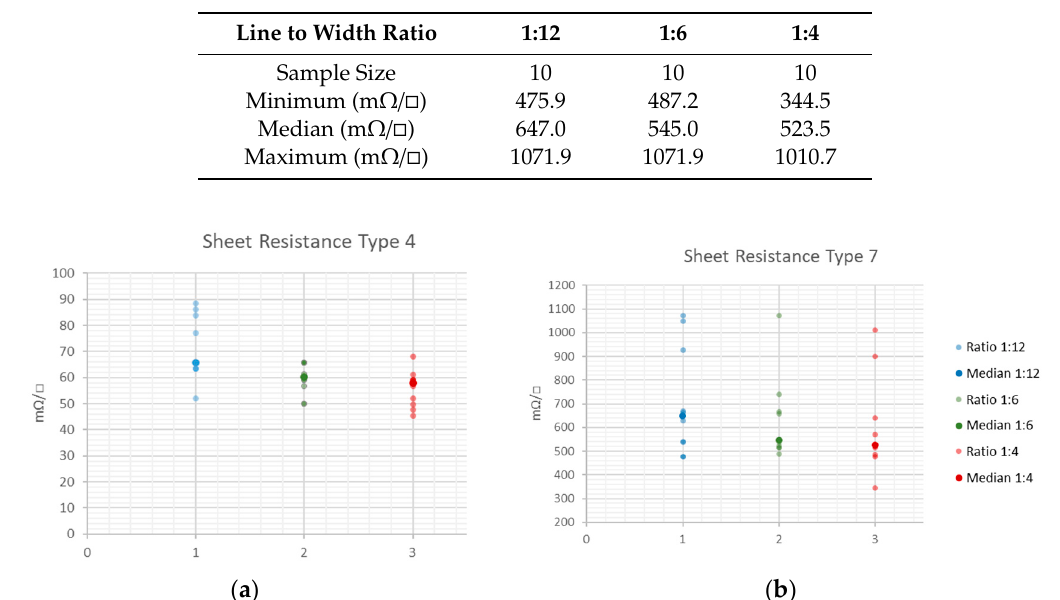
Figure 10. Dispersion of the sheet resistance around the median value of the printed Ag-structures on the type 4 ( a ) and type 7 ( b ) paper substrates.